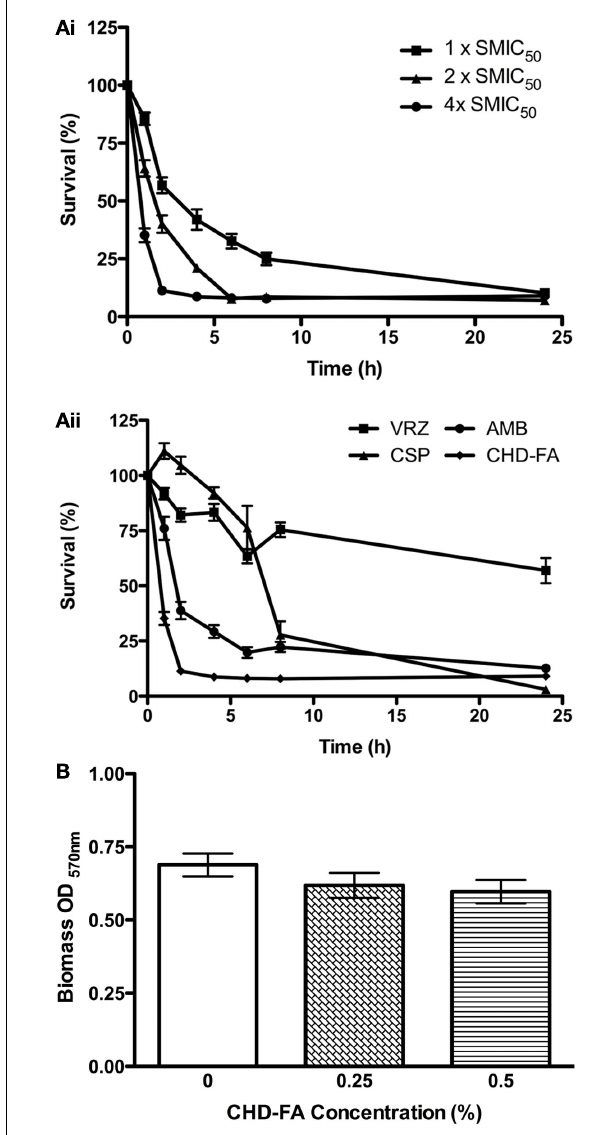
FIGURE 1 | Candida albicans biofilm killing by CHD-FA is time and concentration dependent, despite no biofilm disruption. (A) Biofilm time-kill kinetics of CHD-FA at 1, 2, and 4 × SMIC 50 . (i) Biofilm time-kill kinetics ofVRZ, CSP, AMB and CHD-FA at 4 × SMIC 50 . (ii) Standardized C. albicans (1 × 10 6 cells/ml) were grown in flat-bottomed 96-well plates for 24h, washed in PBS and treated with antifungal agents at defined concentrations for 1, 2, 4, 6, 8, and 24h. Metabolic activity of treated biofilms was then quantified using the XTT assay. Four isolates were used for each assay, and this was performed on two independent occasions in triplicate. (B) Standardized C. albicans (1 × 10 6 cells/ml) were grown in flat bottomed 96-well plates for 24h, washed in PBS and treated with 0.25 and 0.5% CHD-FA for 24h. A negative control was also included.The biomass of the biofilm was then quantified by staining each biofilm with 0.05% w/v crystal violet solution.The biofilms were washed, allowed to air dry, and 100% ethanol applied to destain each biofilm.The biomass was quantified spectrophotometrically by reading at 570nm in a microtiter plate reader (FLUOStar Omega, BMG Labtech). Forty isolates were tested during this assay, which was performed in